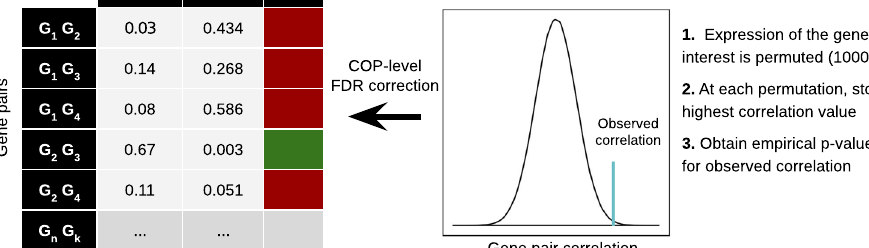
Fig. 1 Local gene co-expression identi fi cation approach. Inter-individual gene expression correlation is calculated for each gene pair whose TSSs are within 1 Mb of each other. For each gene, observed correlation values are compared to expected correlation values when shuf fl ing expression values across individuals. Gene pairs passing the FDR threshold are considered COPs (see the “ Methods ”